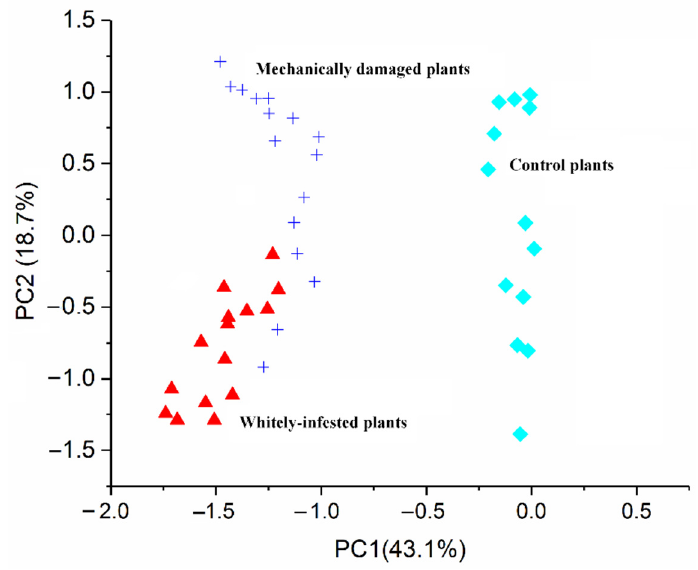
Figure 9. PCA result of the three plant groups detected by E-nose system.